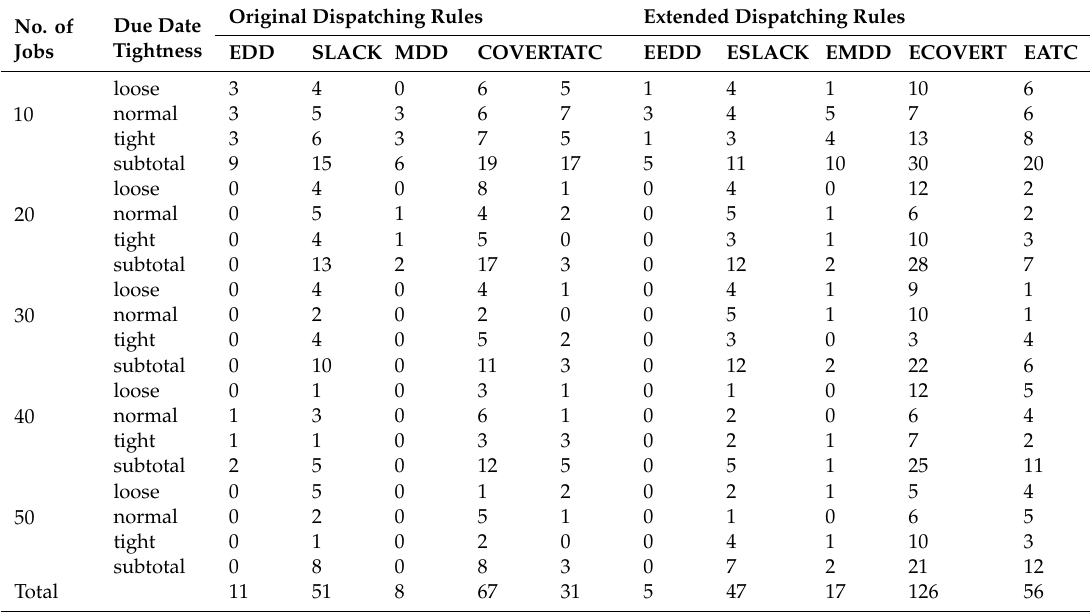
Table 2. Number of the best solutions found by five dispatching rules and their extended